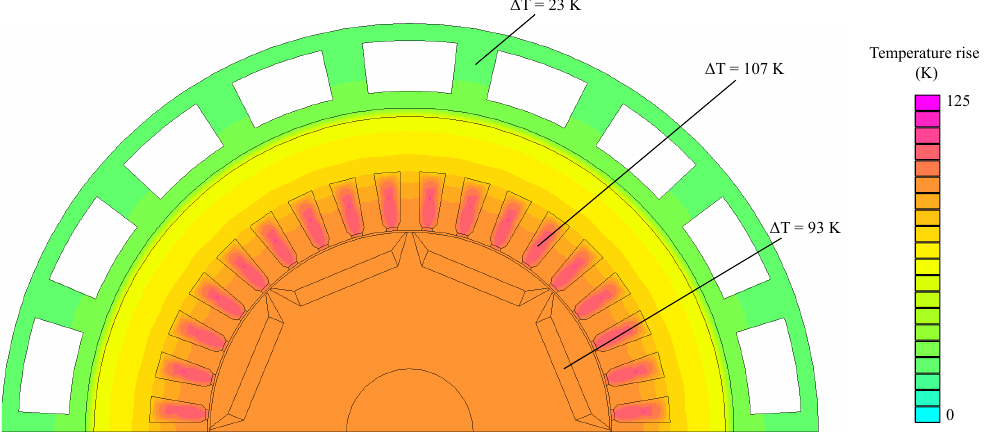
Figure 35. Temperature increase map for the IPM motor with a water cooling